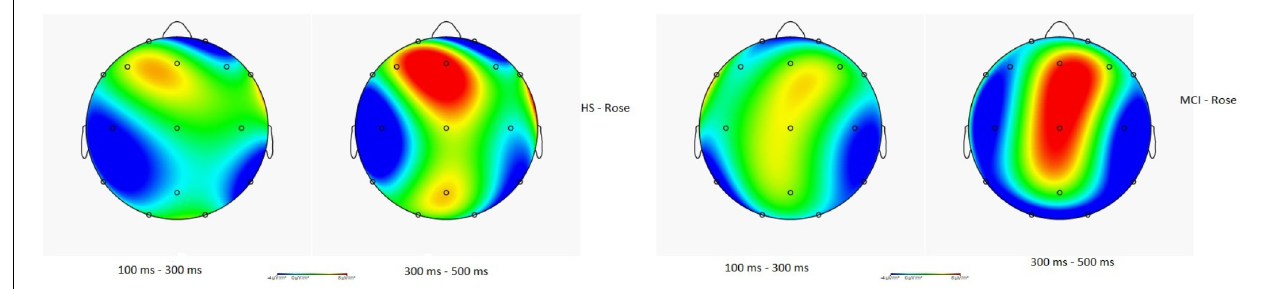
FIGURE 4 | Topographical map of current source density in the N1 and LPC intervals in the HS and MCI group when presented with the rose odorant.